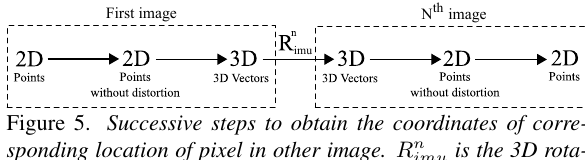
is the 3D rota- imu